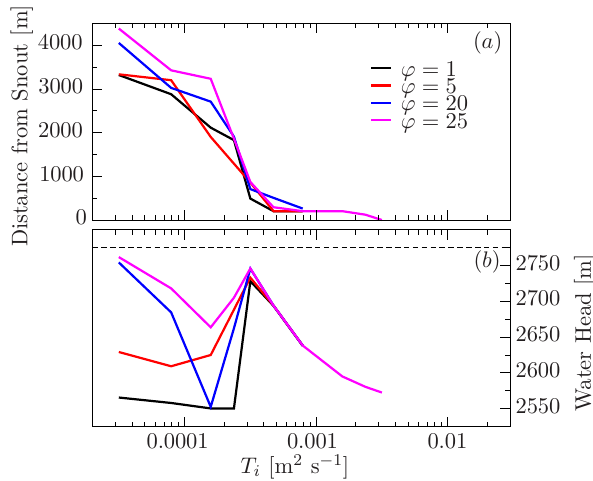
Fig. 8. Evolution with time for different values of the IDS transmis- sivity of (a) the maximum length of the modelled EPL (lines) and (b) the IDS water head. The position of the head of the channelized drainage system derived from observations (black dots) is presented in (a) for comparison. The dashed line in (b) represents the flota- tion limit. Simulations are performed with a constant EPL transmis- sivity T e = 7 . 9 × 10 − 2 m 2 s − 1 and a constant leakage length scale ϕ =